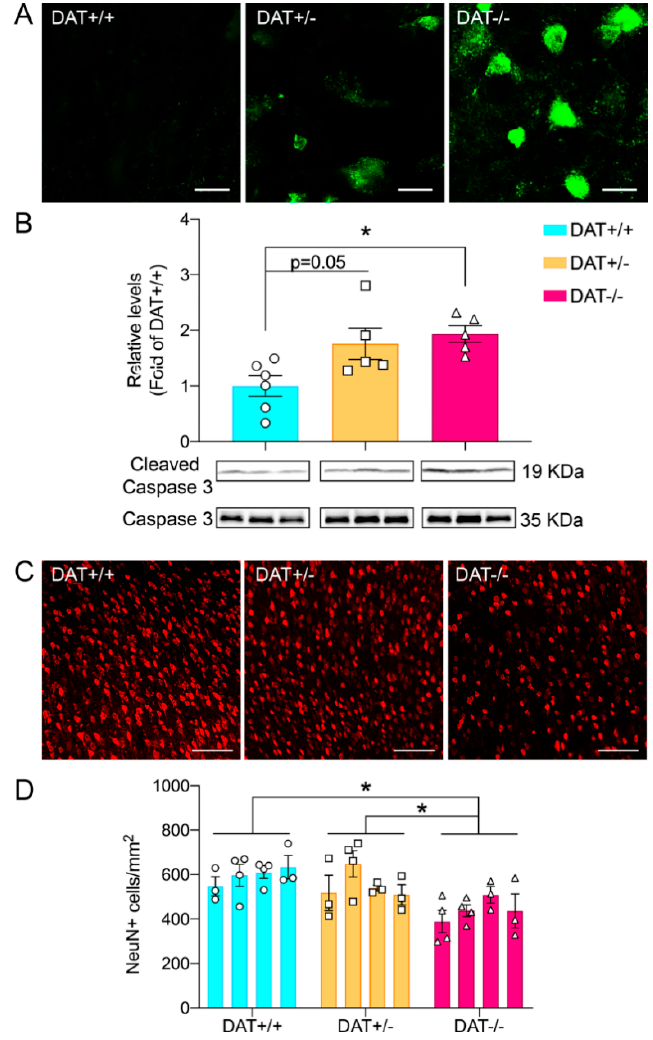
Figure 3. Effects of DAT ablation on neuronal cell death in the prefrontal cortex. ( A ) Fluoro-Jade staining in DAT+/ − and DAT − / − rats displaying degenerating neurons in DAT − / − rats. Scale bar: 3 μ m; ( B ) DAT − / − rats showed a significant increase in levels of cleaved caspase 3. ( C ) Reduction in numbers of NeuN + cells in prefrontal cortex (PFC) of DAT − / − rats. Scale bar: 20 μ m ( D ). Quantitation of NeuN + cells in PFC. Three to four images were analyzed, n = 4 rats for each genotype; individual data points are shown. Data are presented as mean ± SEM, * p < 0.05.